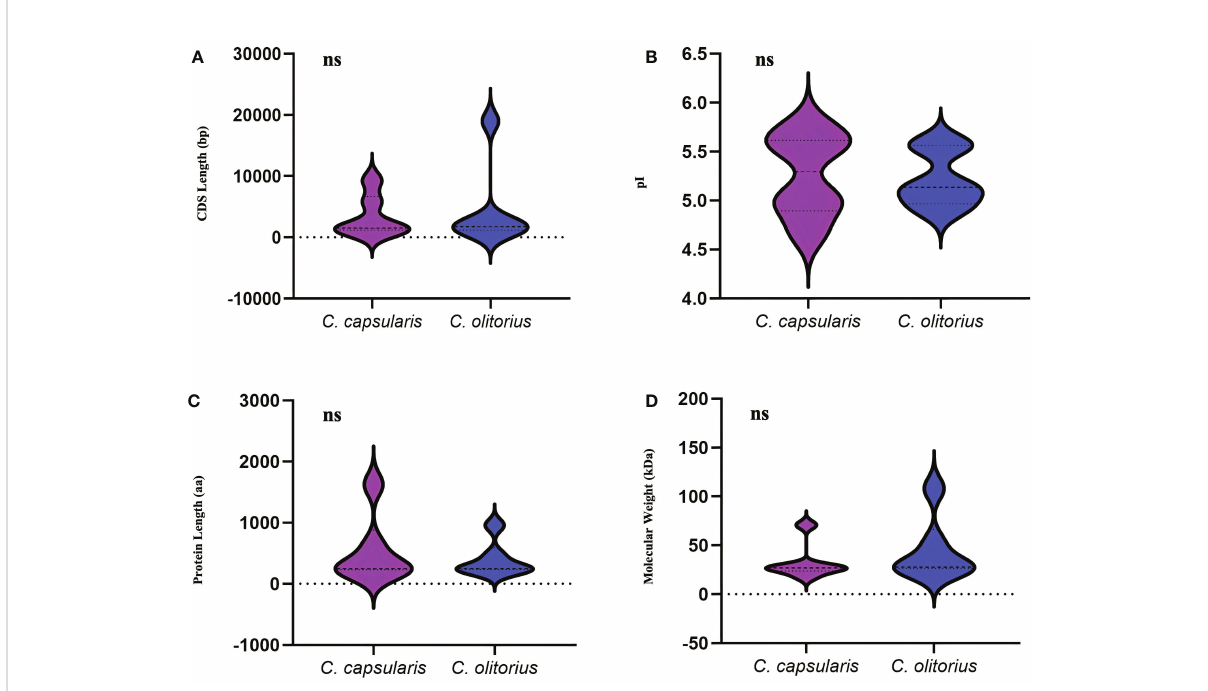
FIGURE 2 Overview of the physical and chemical properties of the CCoAOMT family members in two jute species. (A) CDS length of CCoAOMT genes and (B) Sum of amino acid residues in CCoAOMT proteins. (C) The molecular weight of CCoAOMT proteins. (D) The isoelectric point of CCoAOMT proteins. The ‘ ns ’ means no signi fi cant